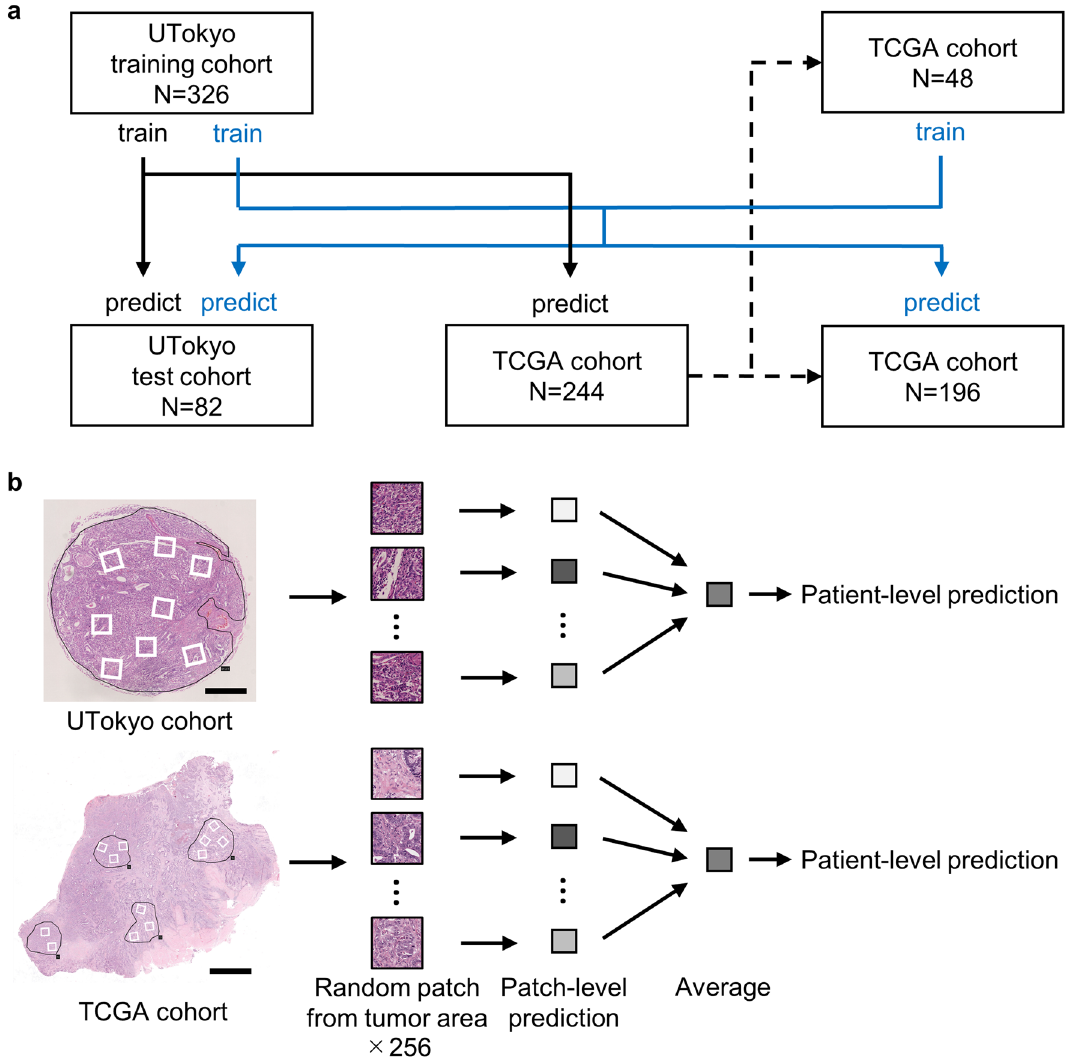
Figure 2. ( a ) The number of patients included in this study. Black solid lines represent the training with only UTokyo cohort, and blue solid lines represent the training with UTokyo cohort and a part of TCGA cohort. ( b ) The flow of patient-level prediction. Scale bar: 0.5 mm (UTokyo cohort), 2.5 mm (TCGA cohort). UTokyo- University of Tokyo, TCGA- The cancer genome